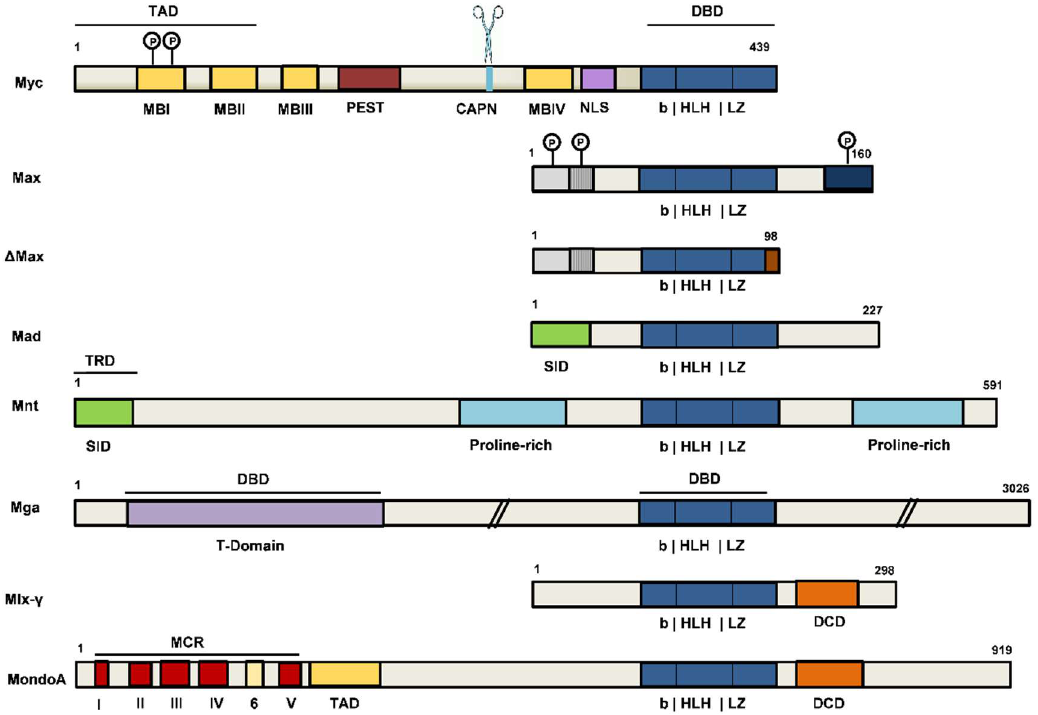
Figure 3. Structure-function schematic of the members of the extended Myc/Max network. Known functional domains of different network members are summarized. TAD: transactivation domain; DBD: DNA binding domain; P: position of known phosphorylation sites; SID: mSin3 interaction domain; TRD: trans-repression domain; T-domain: T-box DNA binding domain; DCD: dimerization and cytoplasmic localization domain. MCR: MondoA conserved region. Not drawn to scale. See text for details.